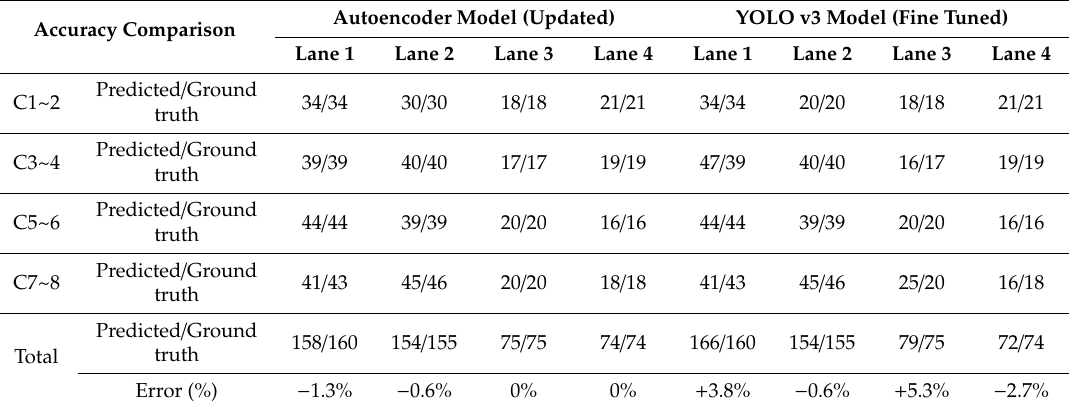
Table 4. The accuracy comparison between the updated model and reference model.